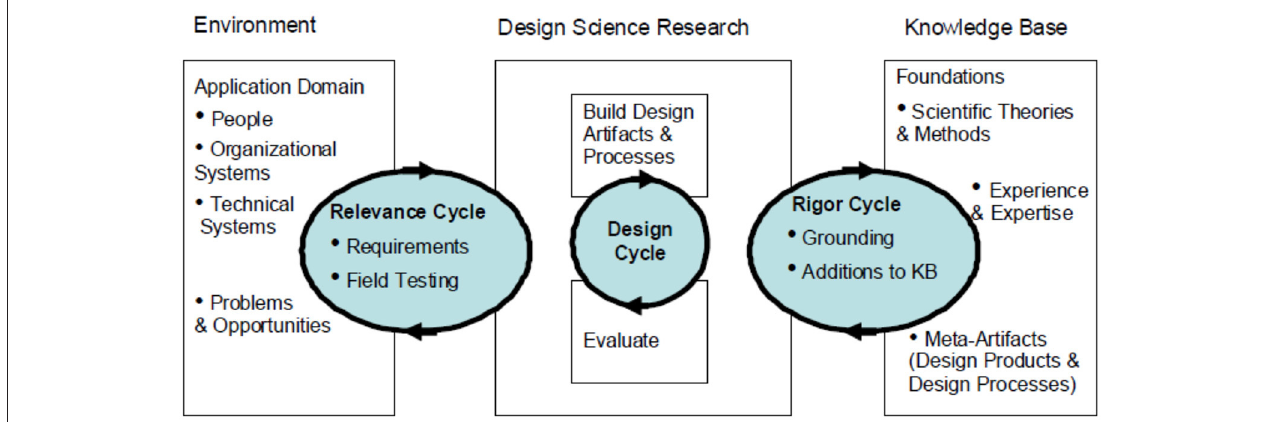
FIGURE 1 | Design science research process (Adopted from Hevner,